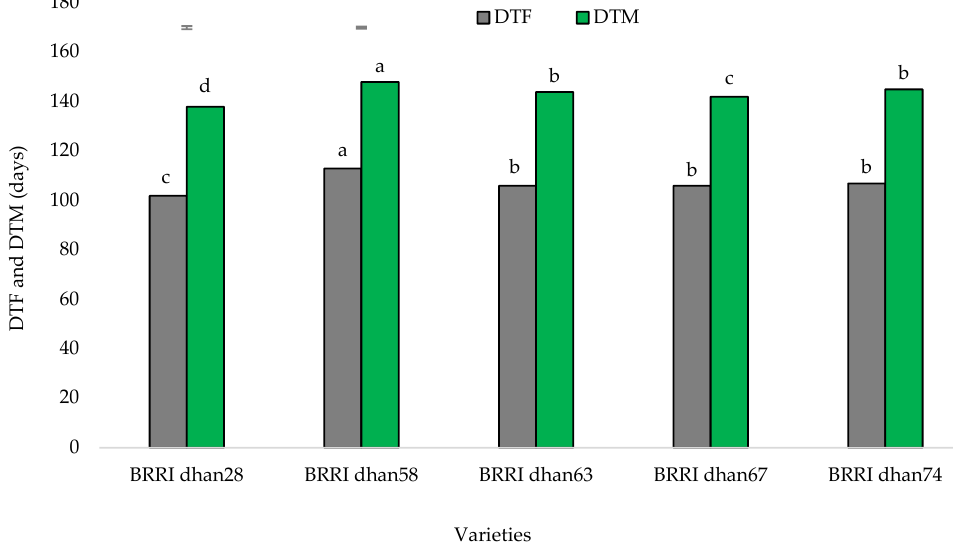
Figure 3. Effect of rice varieties on the days to 50% flowering (DTF) and 80% maturity (DTM). The means with similar letters do not differ significantly at p ≤ 0.05.